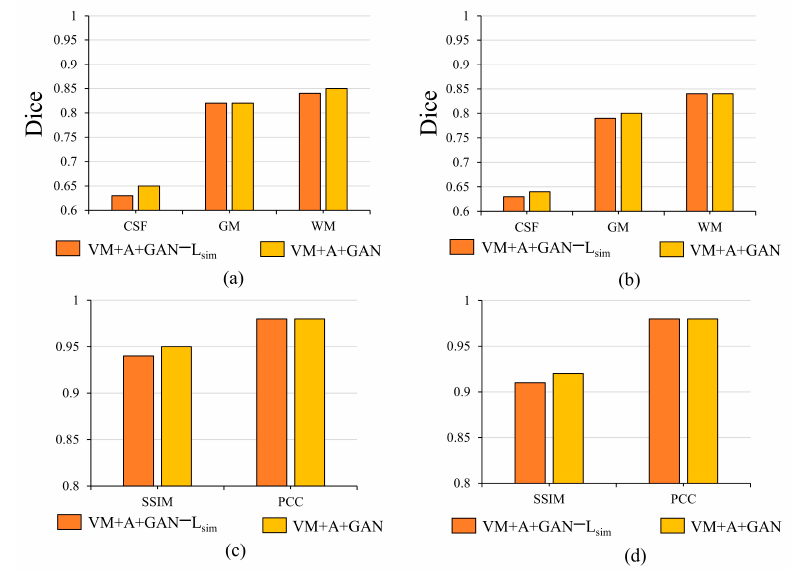
Figure 8. Influence of L sim loss function on registration results.